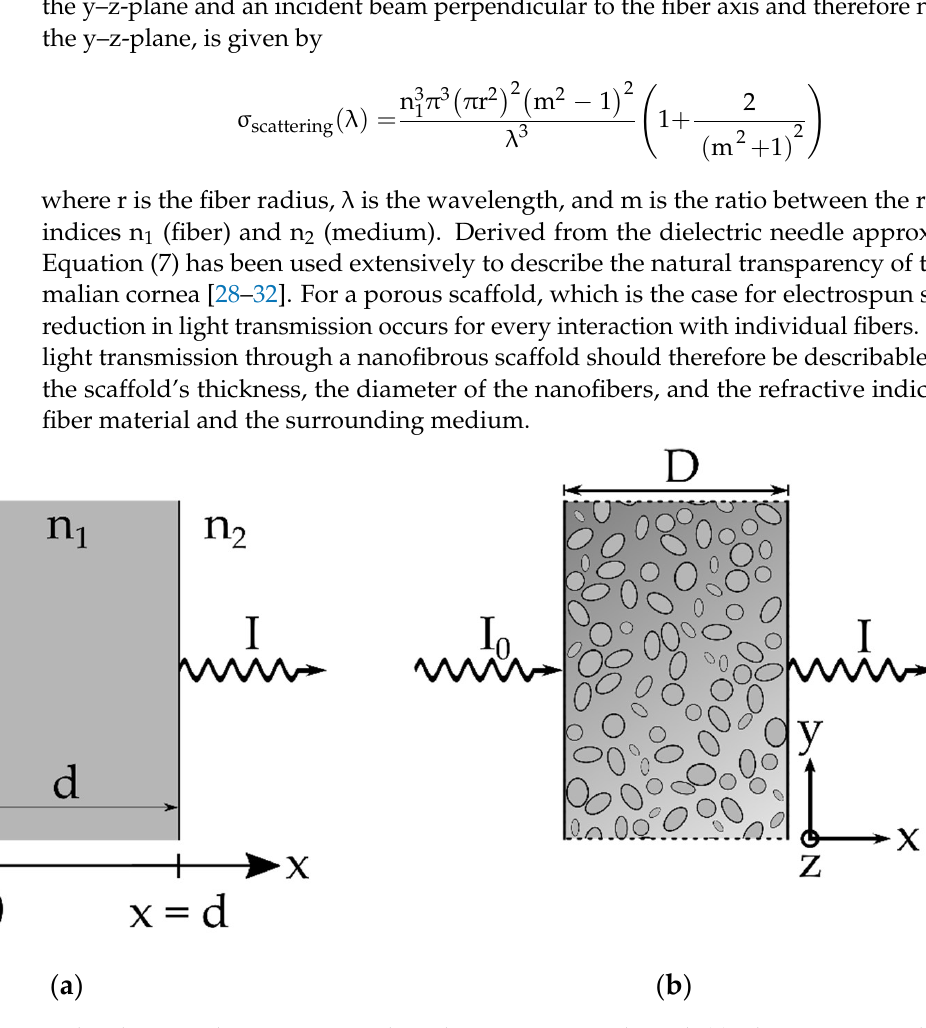
Figure 1. Schematic of an incident beam with intensity I 0 in the x direction passing through ( a ) a homogenous volume of thickness d with the optical interfaces at the n 2 /n 1 and n 1 /n 2 transitions and ( b ) a planar scaffold in the y–z-plane of thickness D, consisting of single nanofibers with fiber diameter d. Propagation of the incident beam in the x direction.